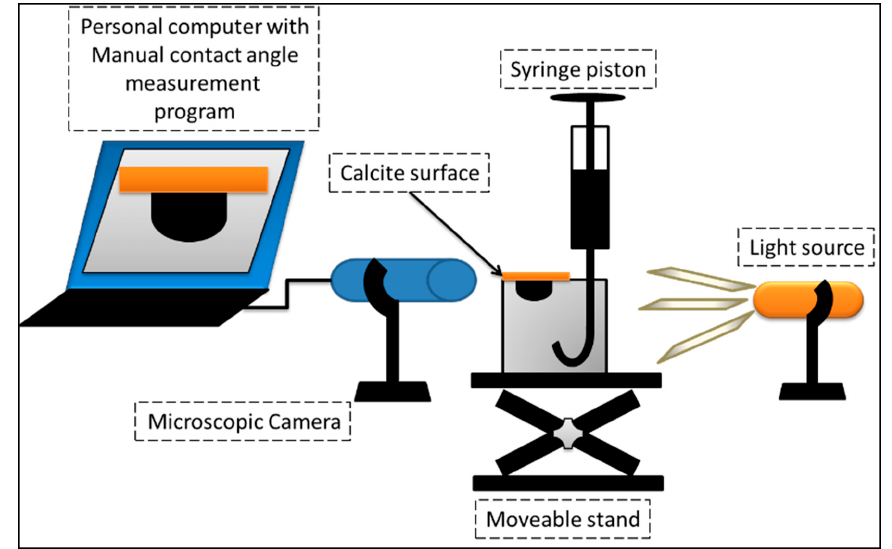
Figure 2. Schematic diagram of the contact angle (CA) measurement system.